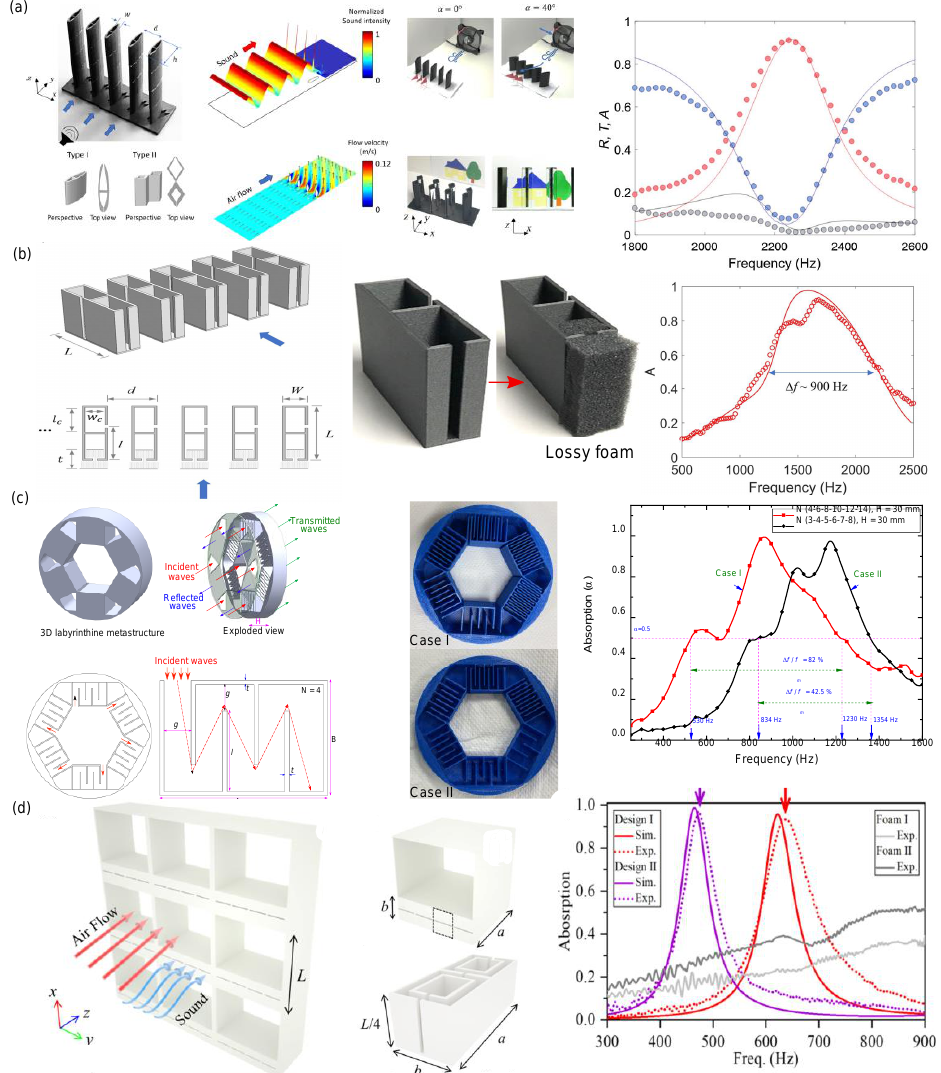
Figure 7. (a) Photographs of the multifunctional sparsely arranged acoustic absorbers (Type I: fish shape, Type II: double-diamond shape). Corresponding measured acoustic spectra (symbols) for the HR pair array are shown. Reprinted with permission from Lee et al. [104], © 2020 American Physical Society. (b) Schematics and photographs of the broadband sparse absorbers composed of dual-